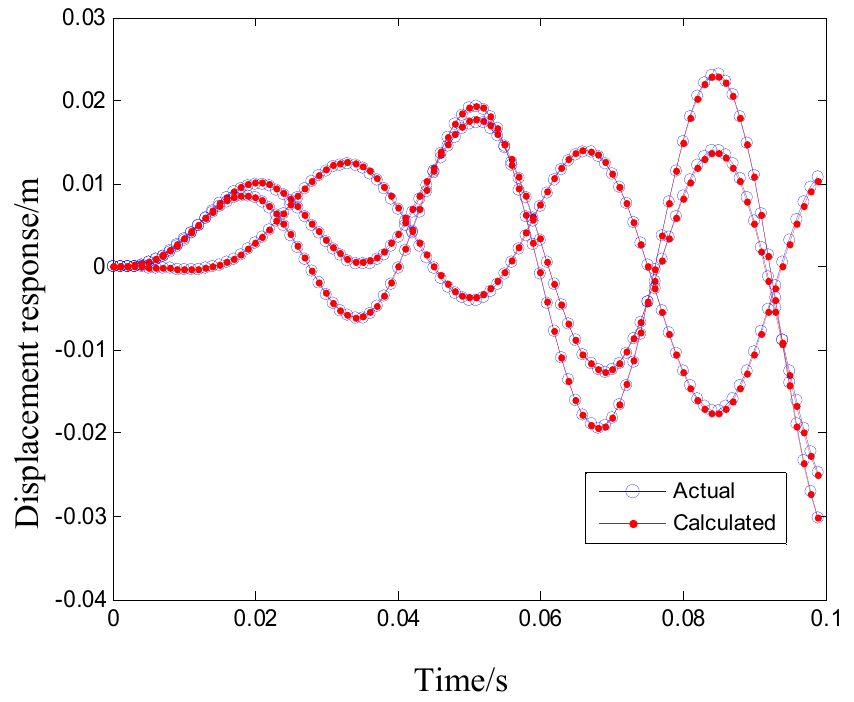
Figure 7. Validity verification of the identified load median function by response comparison.